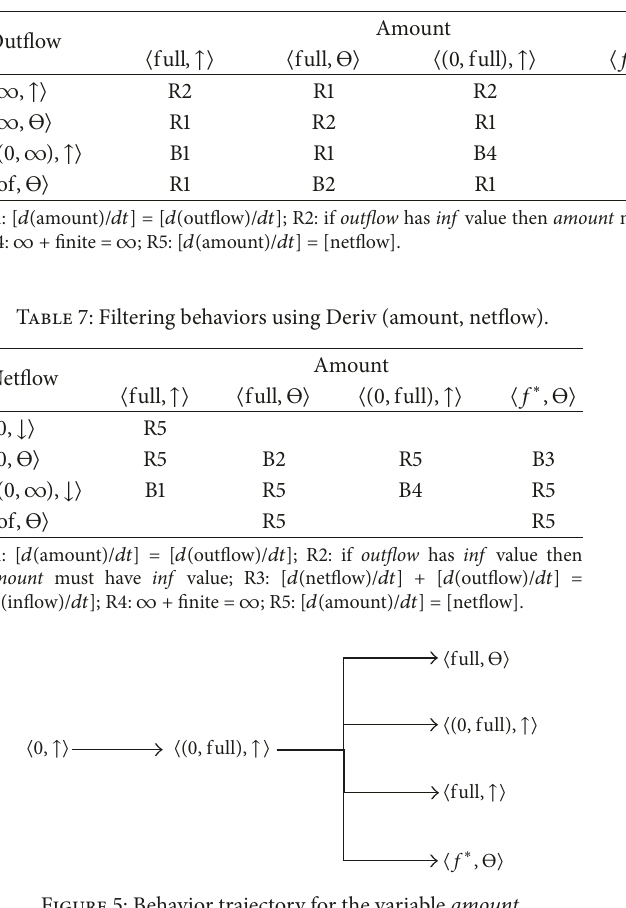
Figure 5: Behavior trajectory for the variable